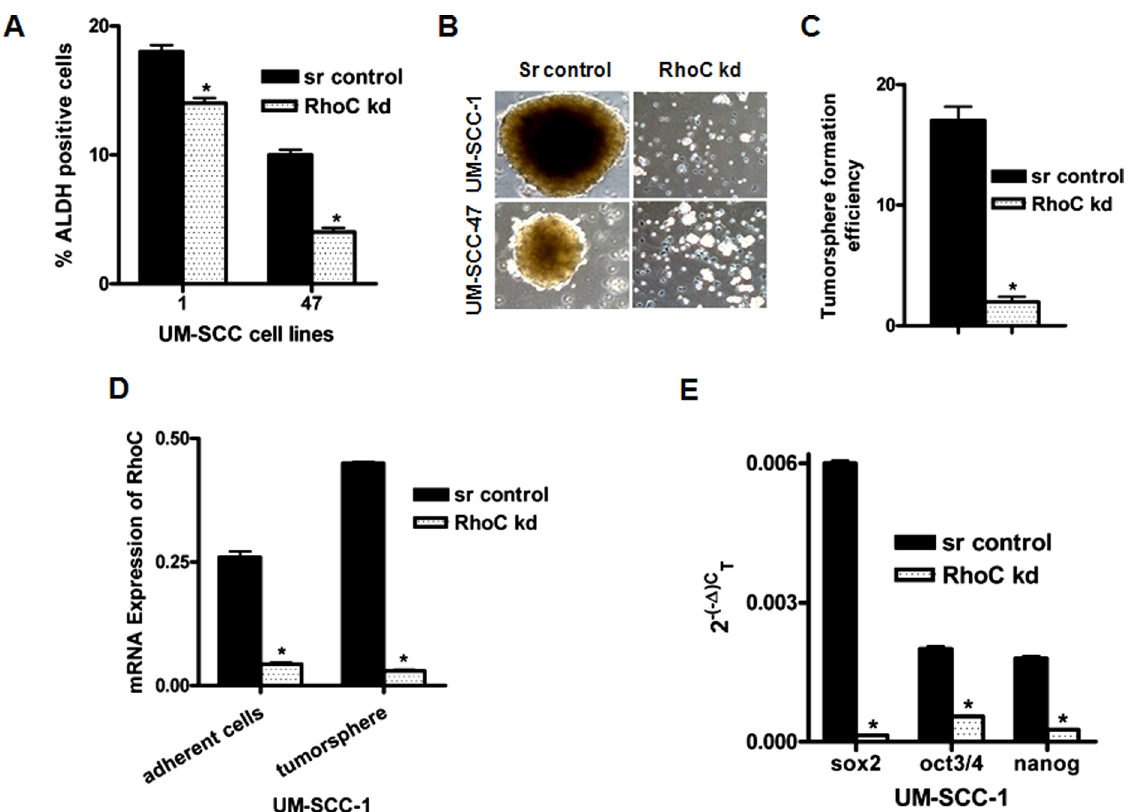
Figure 3. ALDH expression and tumorsphere formation in scrambled control and RhoC knockdown UM-SCC- cell lines. FACS analysis showing the expression of (A) ALDH in the scrambled control and the RhoC knockdown clones. (B) The tumorspheres formation in the scrambled control and the RhoC knockdown UM-SCC-1 and -47cell lines. (C) The representation of tumorspheres formation efficiency in scrambled control and RhoC knockdown UM-SCC-1 obtained in 96 well plates. A significant decrease in ALDH expression was seen. Tumorsphere formation was dramatically low in RhoC knockdown UM-SCC-1 and -47 respectively. (D) A significant decrease in the RhoC mRNA expression was obtained in the RhoC knockdown adherent cell and in the tumorspheres. (E) Stem cell transcription factors, sox2, oct3/4, and nanog showing significant down regulation in their mRNA as revealed by real time RT-PCR in the scrambled control and the RhoC knockdown spheres obtained from UM-SCC-1.